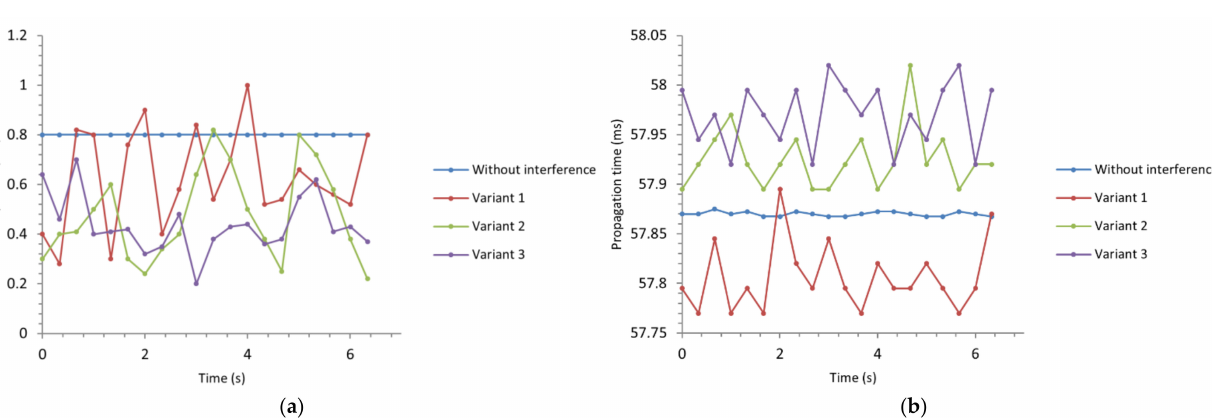
Figure 14. ( a ) Voltage amplitudes recorded in the receiver system, with different arrangements of the sources of interference (AR30); ( b ) Ultrasonic wave propagation time, at distance 20 m (AR30). Analogous tests were carried out with the use of AR41 converters; the results are presented in Figure 15a,b.